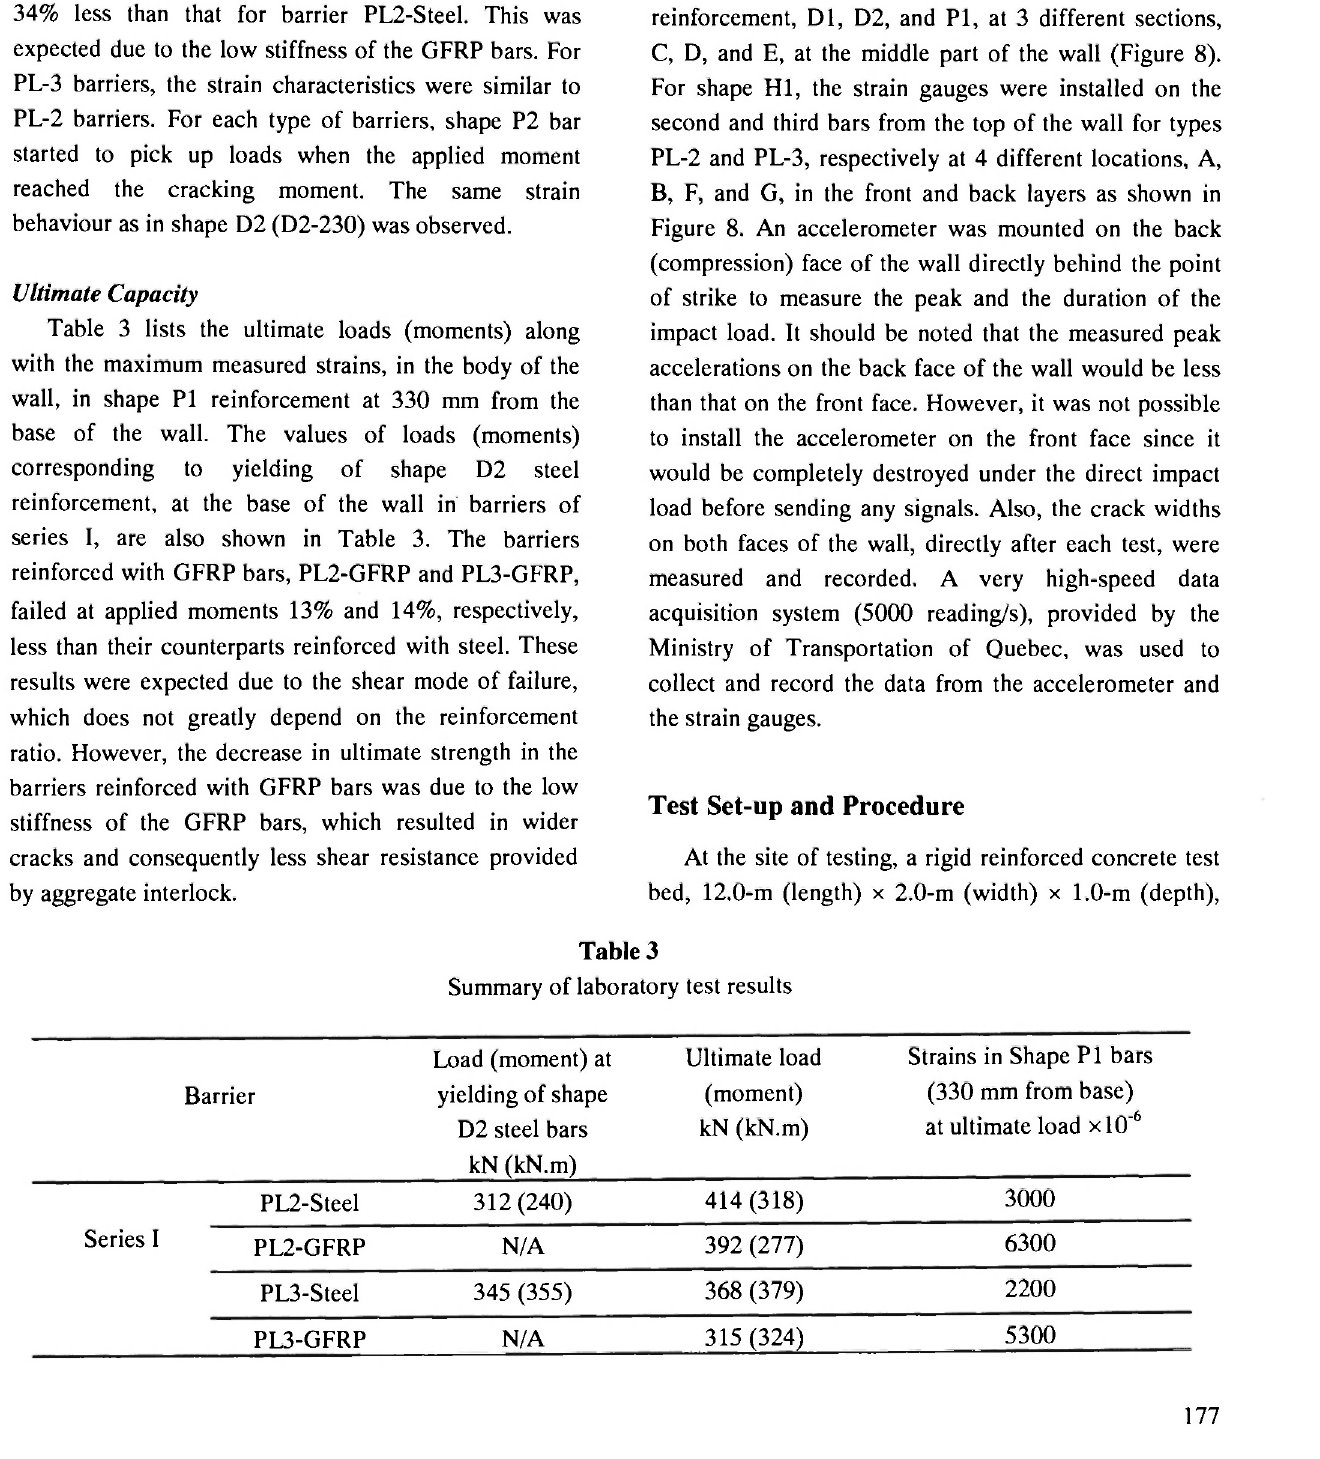
Summary of laboratory test